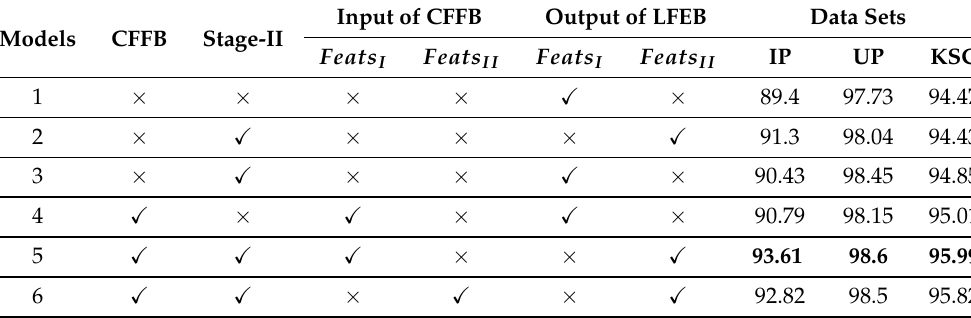
Table 6. Effectiveness analysis (OA%) of CRFB and